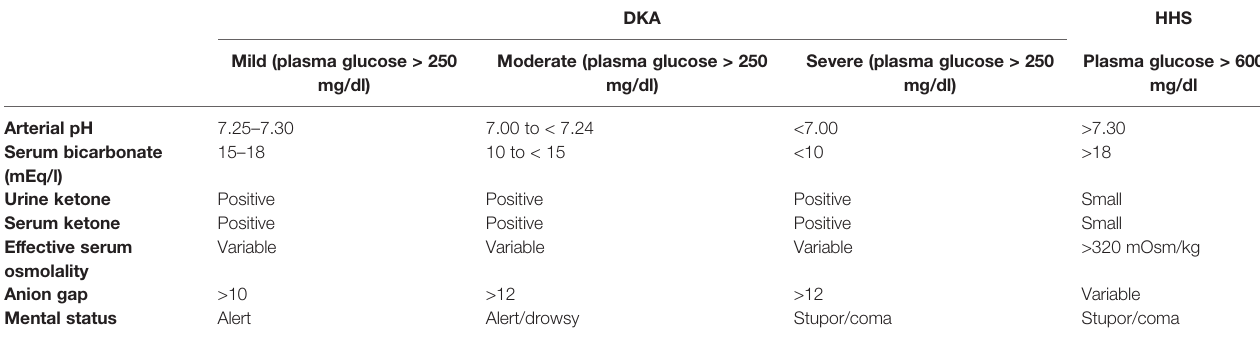
TABLE 1 | Diagnostic criteria for DKA and